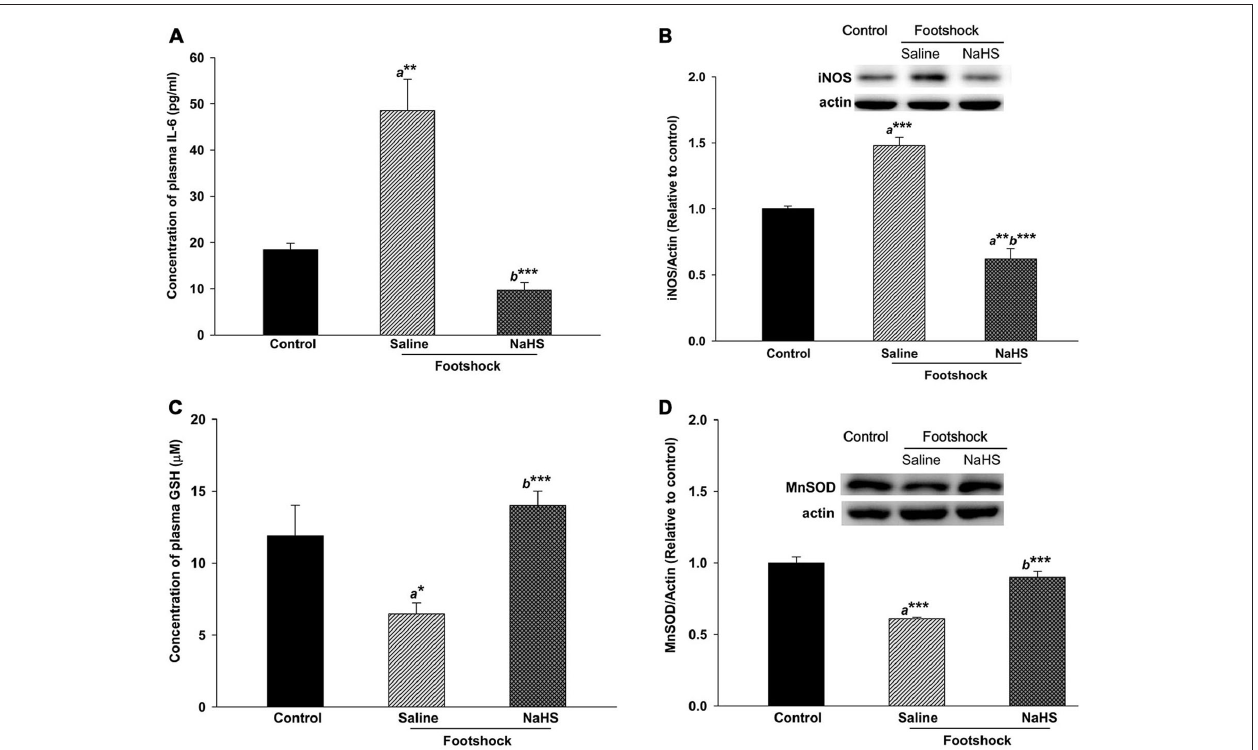
FIGURE 9 | Antioxidative and anti-inflammatory activity of NaHS in mice under footshock. (A) Levels of the inflammatory cytokine IL-6 in mouse plasma analyzed by ELISA. (B) Representative Western blot and densitometry for iNOS in the mouse hippocampus. Footshock strongly induced IL-6 and iNOS, and NaHS ameliorated the inflammation. (C) Concentrations of GSH in mouse plasma measured by ELISA. (D) Representative Western blot and densitometry for MnSOD in the hippocampus. Footshock reduced the levels of GSH and MnSOD, and NaHS improved the antioxidant capacity of the mice under footshock. β -Actin was used as an internal control. The data are the mean ± SEM of each group ( n = 3–5 per group). ∗ p < 0.05; ∗∗ p < 0.01; ∗∗∗ p < 0.001. a , compared to the control group. b , compared to the footshock/saline group.